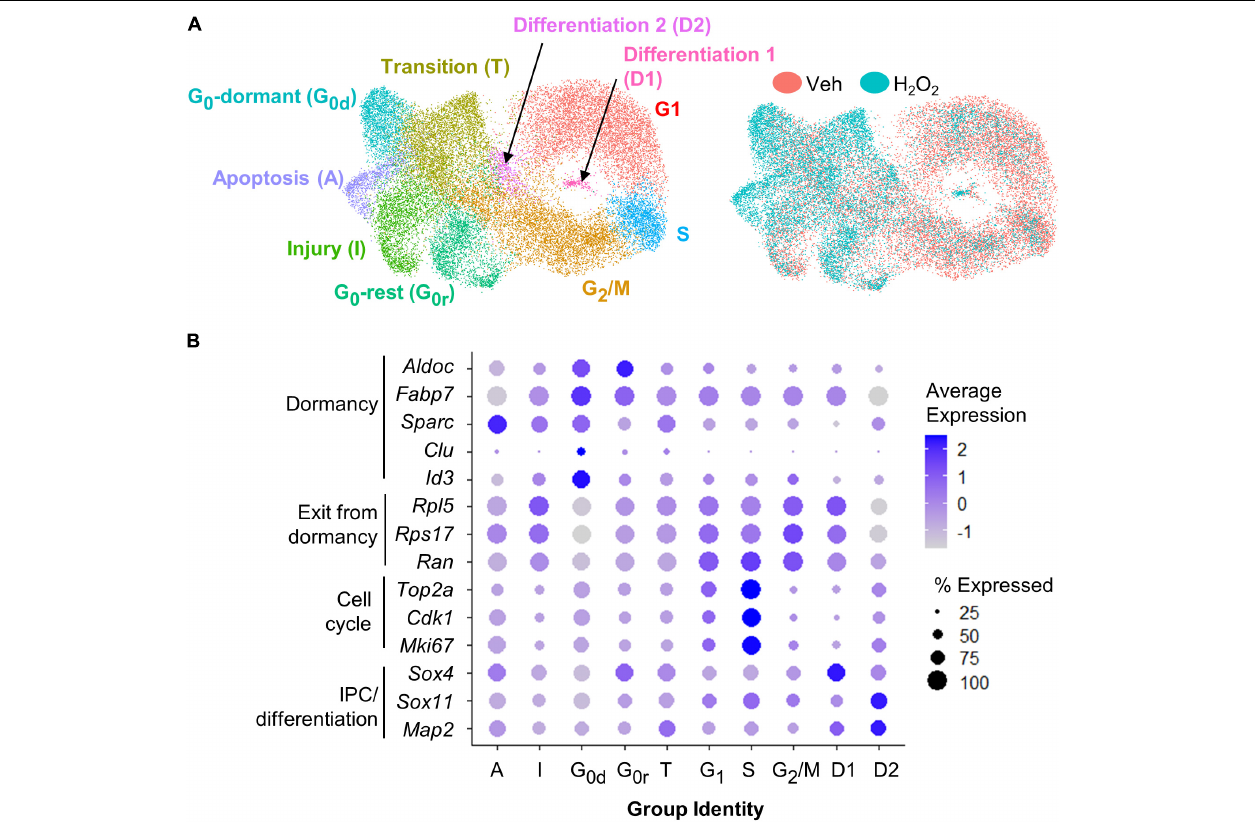
FIGURE 2 | scRNAseq of cultured NSCs in an in vitro model of oxidative stress. (A) UMAP of vehicle and H 2 O 2 -treated cultured NSCs yielded 10 subpopulations defined by gene expression profiles consistent with GO terms associated with various stages of the cell cycle, levels of quiescence or response to injury (left). UMAP comparison of H 2 O 2 -treated versus vehicle-treated NSCs indicated a shift toward quiescence, apoptosis, senescence, and injury response following oxidative stress (right). (B) Dot plot visualization of average expression of and percent of cells expressing select genes known to be associated with quiescence versus activation further confirmed subpopulation